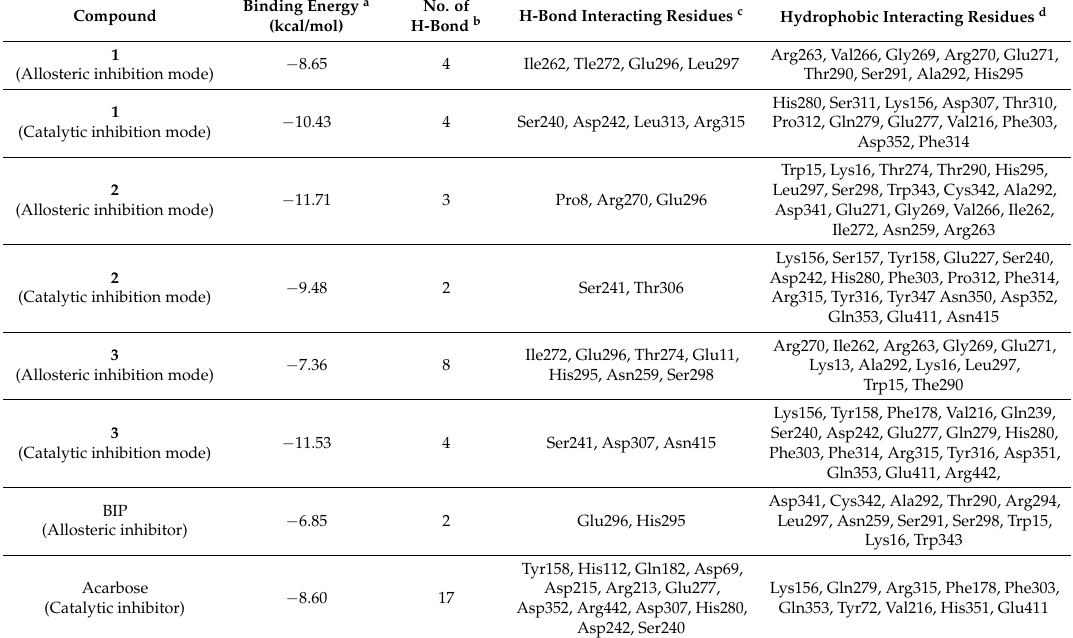
c Hydrophobic Interacting Residues